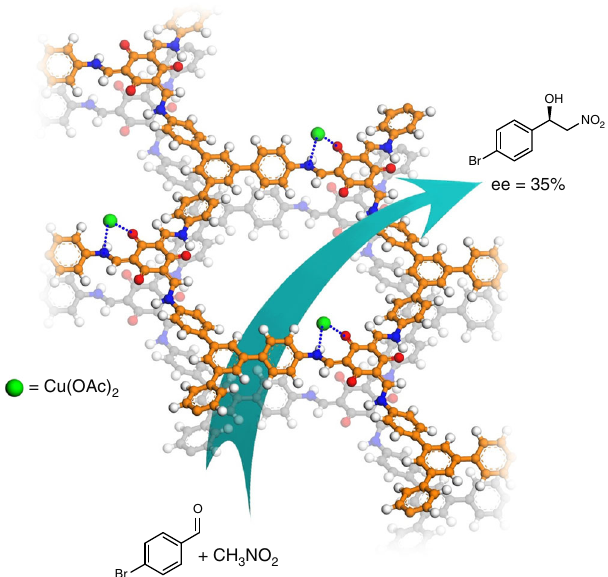
Fig. 8 Henry reaction. The reaction between nitroalkane with aldehyde was catalyzed by